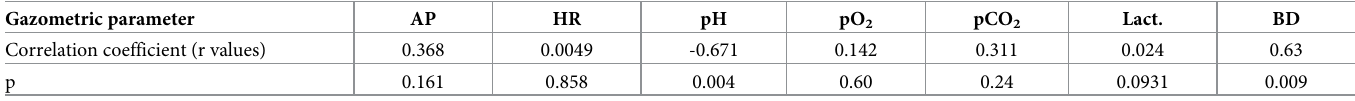
Table 3. Correlation between hemodynamic, gazometric parameters and FSI min during occlusion. Gazometric parameter